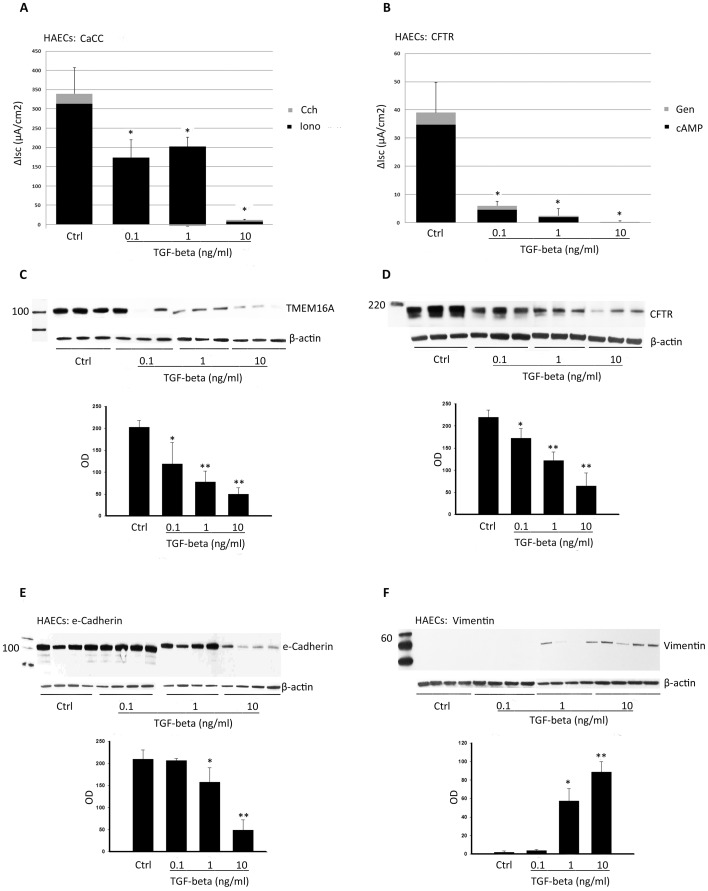
Dose-response effects of TGF-beta on TMEM16A, CFTR, e-cadherin, and vimentin in HAECs.HAECs were treated with TGF-beta (vehicle control, 0.1, 1.0, and10 ng/ml) for 48 h, followed by Using chamber and immunoblot as described in Methods. (A and B) CaCC (*P<0.0016) and CFTR (*P<0.0001) currents were reduced by TGF-beta treatment at every dose used. (C and D) TMEM16A (*P<0.045, **P<0.02) and CFTR (*P<0.04, **P<0.006) expression was suppressed by TGF-beta treatment at every dose used. E-cadherin expression (E) was decreased (*P<0.006, **P<0.0001) and vimentin expression (F) was increased (*P = 0.001, **P<0.0003) with 1 ng/ml or higher TGF-beta treatment.